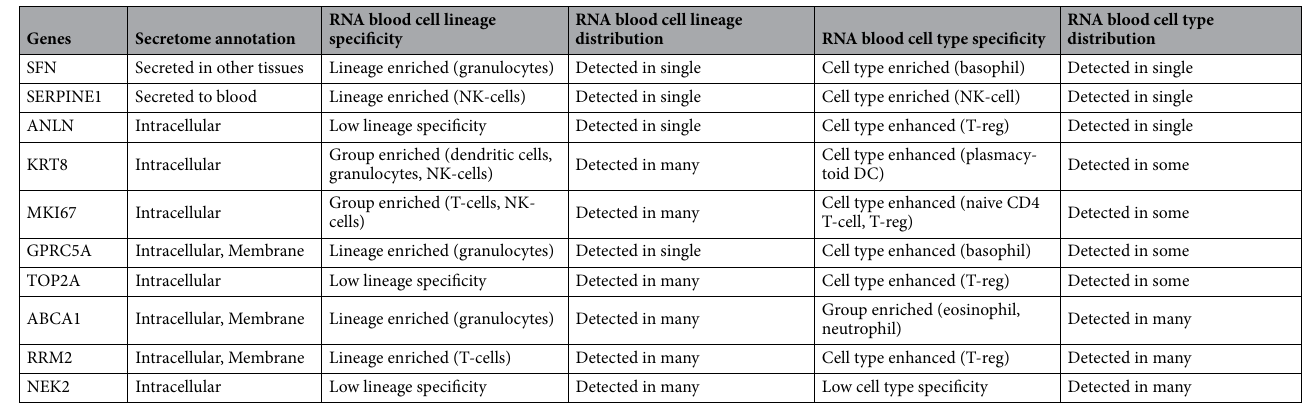
Table 3. Gene’s products and blood or cell lineage using the Human Protein Atlas database were explored https:// www. prote inatl as.